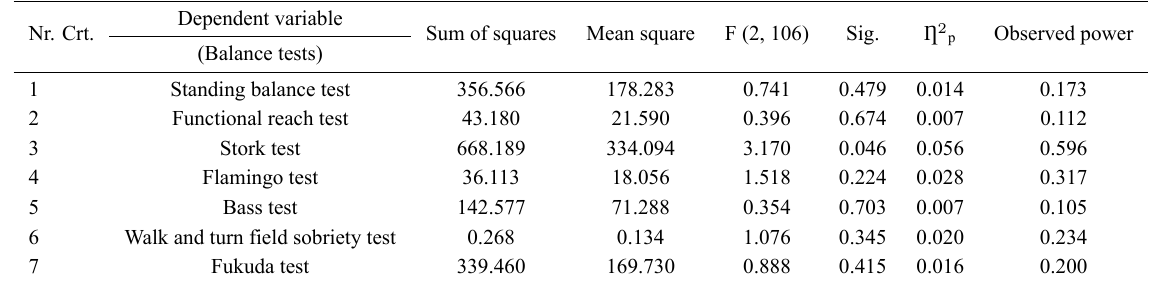
Table 3. The results of the analysis of univariate tests (ANOVA)/The effect of BMI classes on dependent variables (balance tests). Nr. Crt.